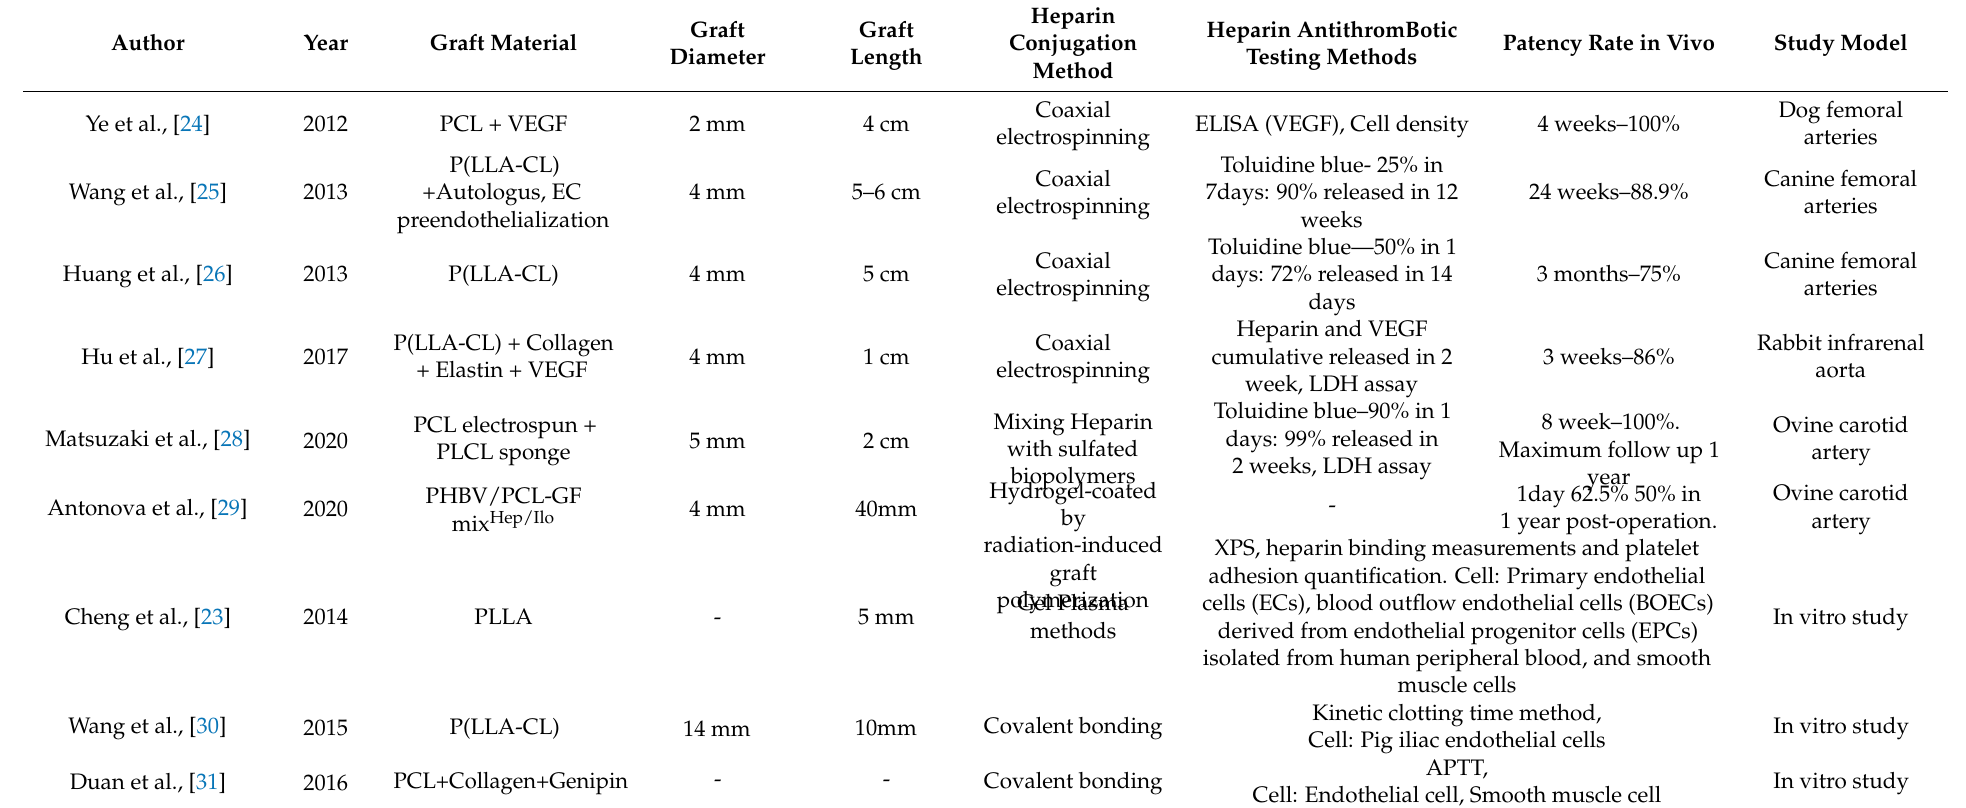
PCL: polycaprolactone, VEGF: vascular endothelial growth factor, PLLA: poly(L-lactic acid), EC: endothelial cell, PU: polyurethane, PEG: peptides coimmobilized graft, G:GRGDS, Y:YIGSR, PLCL: poly-l-lactide- ε -caprolactone, ELISA: enzyme-linked immunosorbent assay, XPS: X-ray photoelectron spectroscopy, LDH: lactate dehydrogenase, EDC: 1-Ethyl-3-[3-dimethylaminopropyl]carbodiimide hydrochloride, NHS: